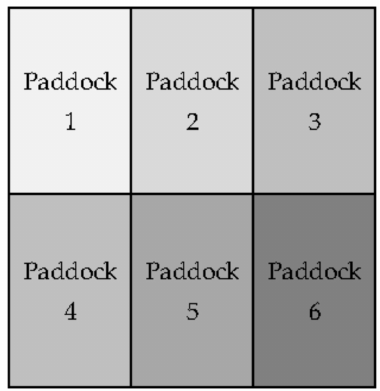
Figure 1. Paddock set up in Study